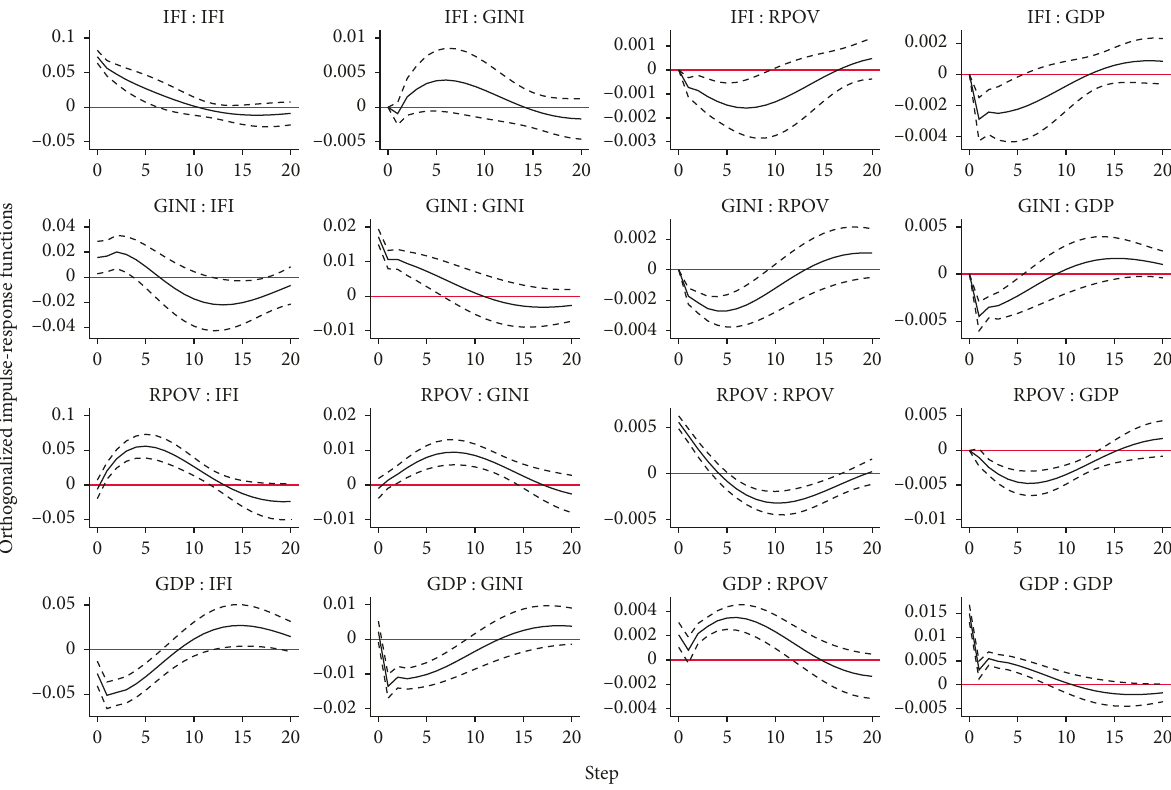
Figure 4: Impulse response function in the central region.